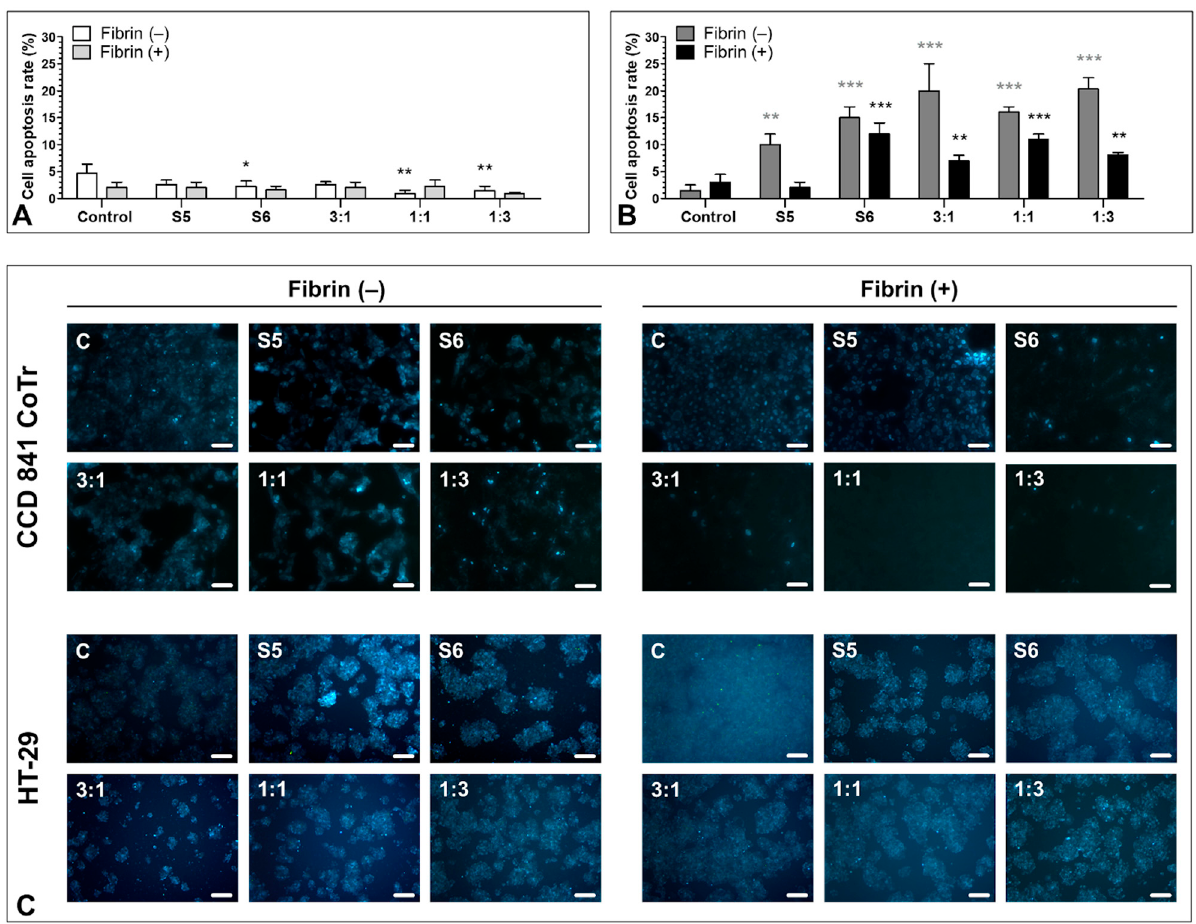
Figure 6. Pro-apoptotic effect of the fractions. Effect of apoptosis induction in the CCD 841 CoTr ( A ) and HT-29 cells ( B ) evaluated with Hoechst 33342/PI staining. ( C ) shows a representative microscopic image of cells influenced by the tested fractions. The studied fractions, administered at 300 µg/mL, exerted a proapoptotic effect, which was stronger in the case of the fraction administered in the 3:1, 1:1, and 1:3 ratios. Fibrinogen exerted an antiapoptotic and protective effect on the HT-29 cells. However, the number of apoptotic cells was still higher than in the control (excluding the S5 fraction). * p < 0.05; ** p < 0.01; *** p < 0.005; one-way ANOVA, n = 3, post hoc: Dunnett’s test. The scale bars represent 200 µm.